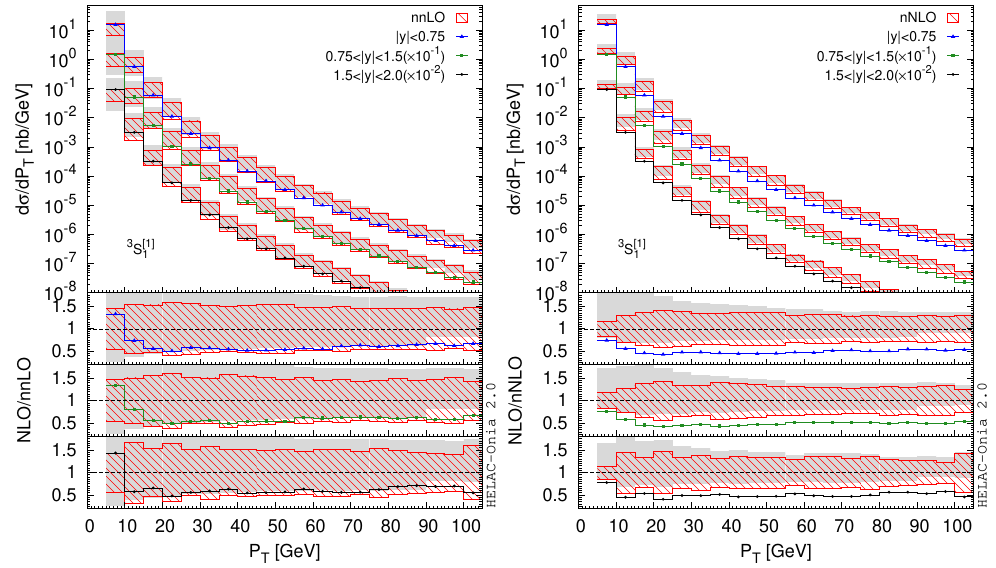
Figure 12 . Comparisons of spin-summed differential cross sections for the Fock state 3 S [1] nnLO (left), nNLO (right) calculations and the complete NLO calculations.